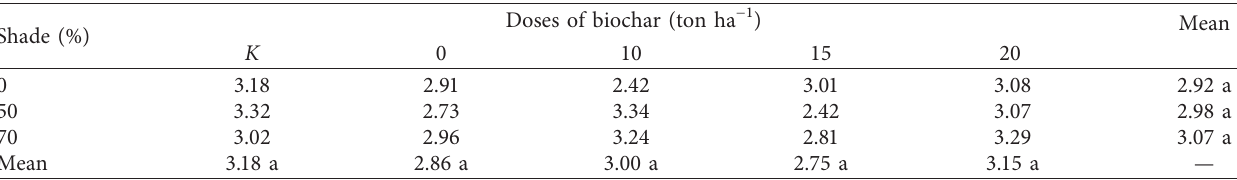
Table 4: Effects of biochar and shade application on the soil organic matter (%).